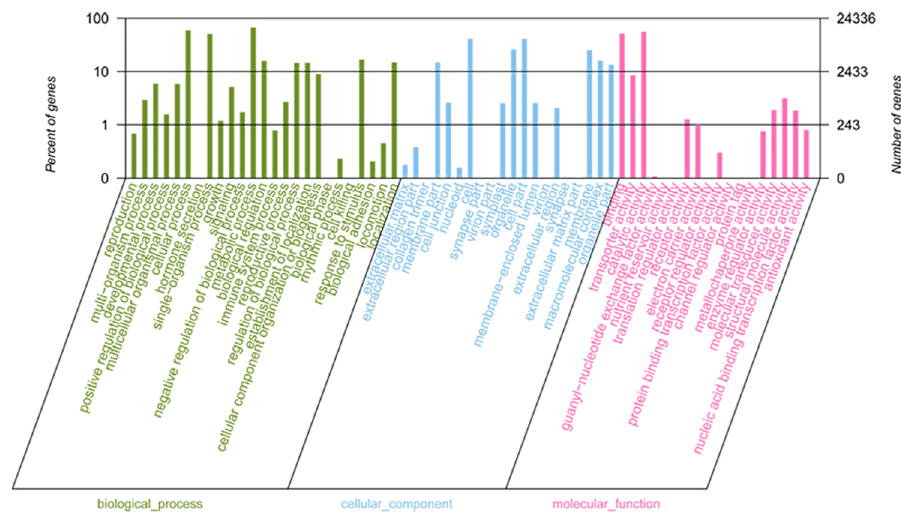
Fig 2. Gene Ontology (GO) term level2 categories of unigenes of C . officinalis